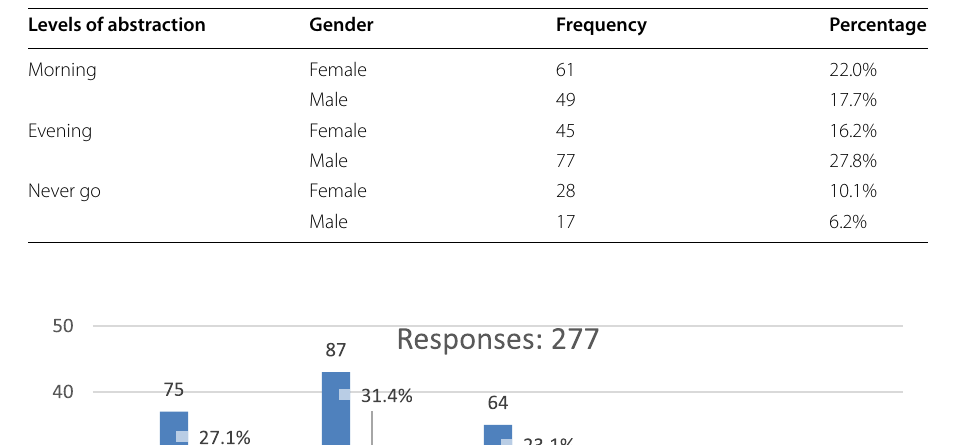
Table 3 The time you spend more in the spaces between buildings in one day